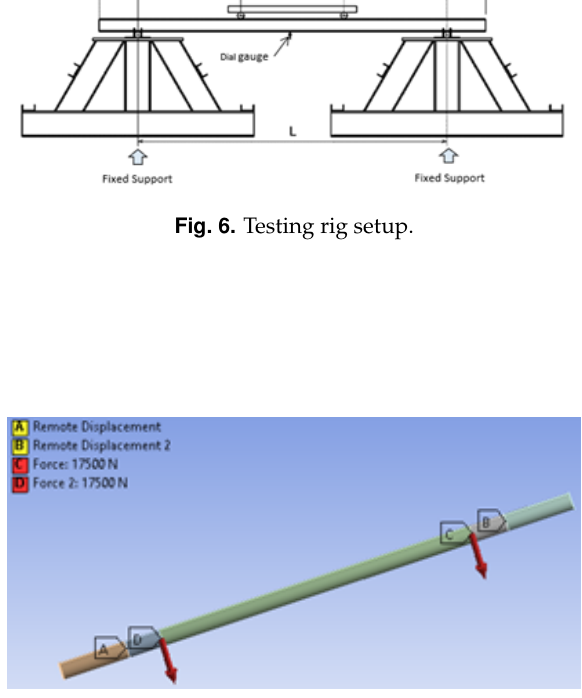
Fig. 4. (a)(b): FEA result of specimen. Table 2. specimen FEA result.